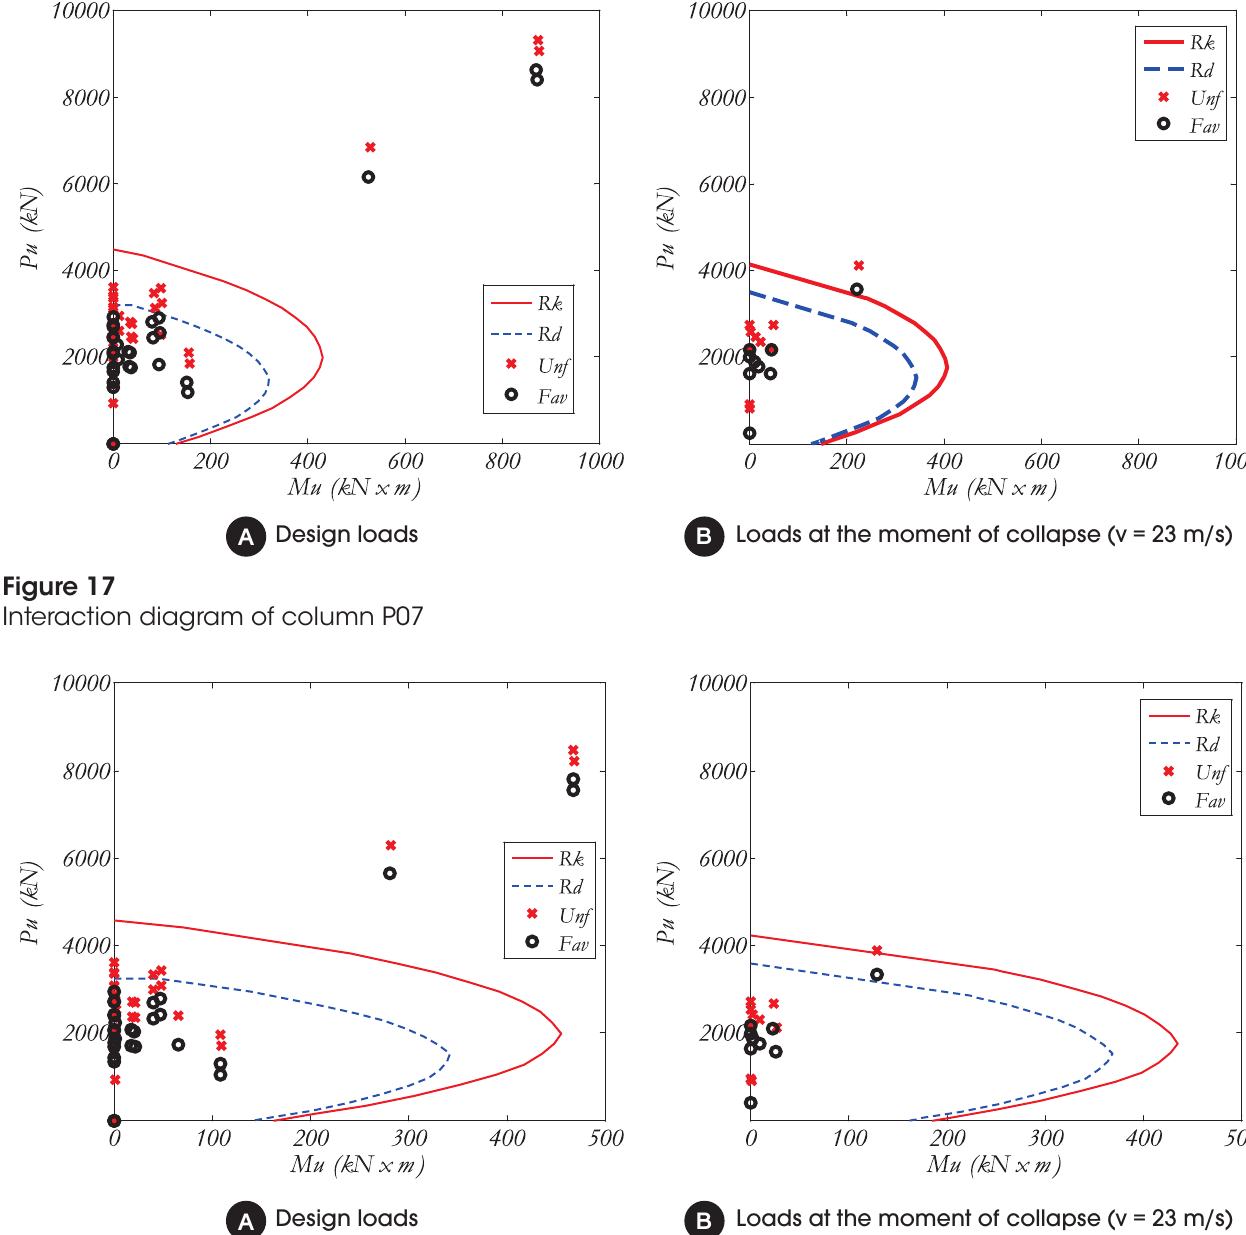
A Design loads B Loads at the moment of collapse (v = 23